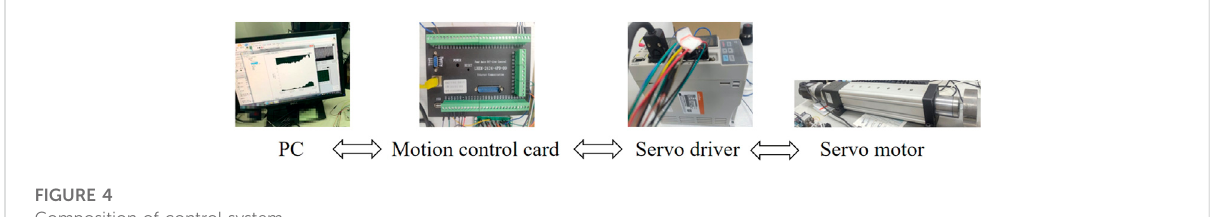
FIGURE 4 Composition of control system.